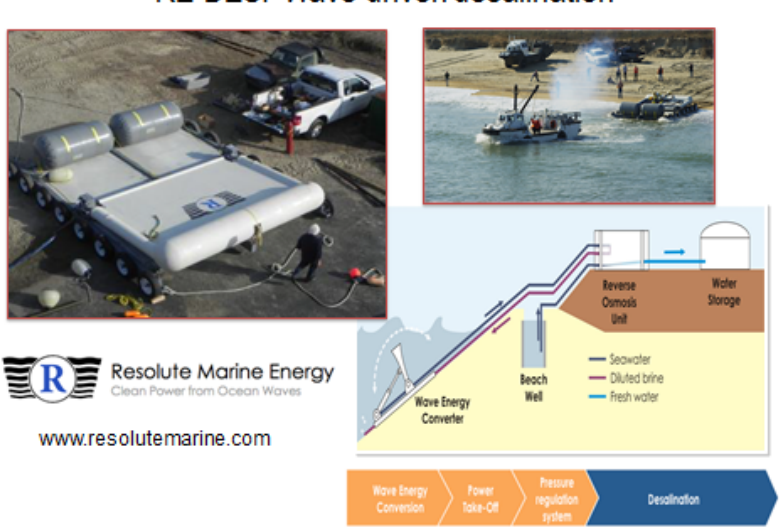
Figure 9. Pictures of Wave 2 O TM at Cabo Verde (courtesy of Resolute Marine) and system layout of the Wave20 TM desalination system [102]. the Wave 2 O TM desalination system